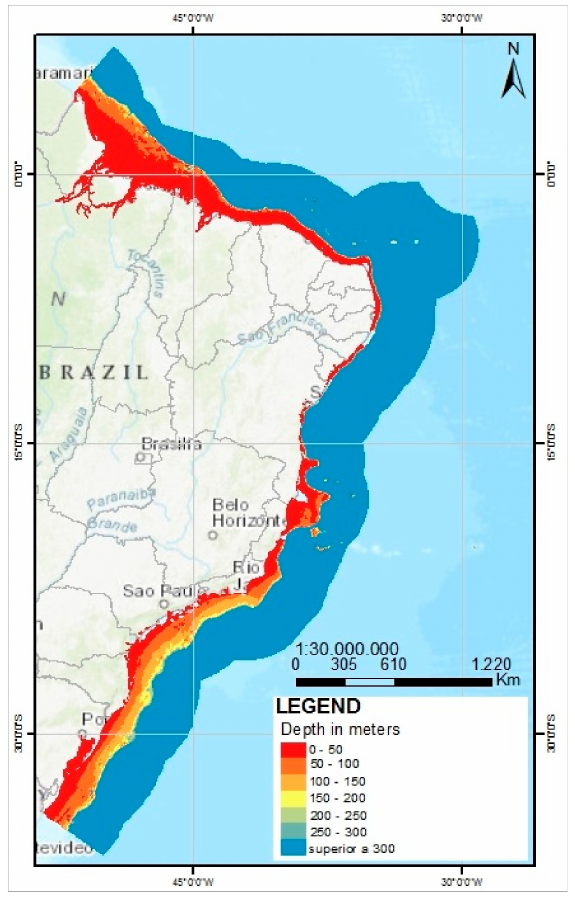
Figure 4. EEZ depth ranges—bathymetry. Source: